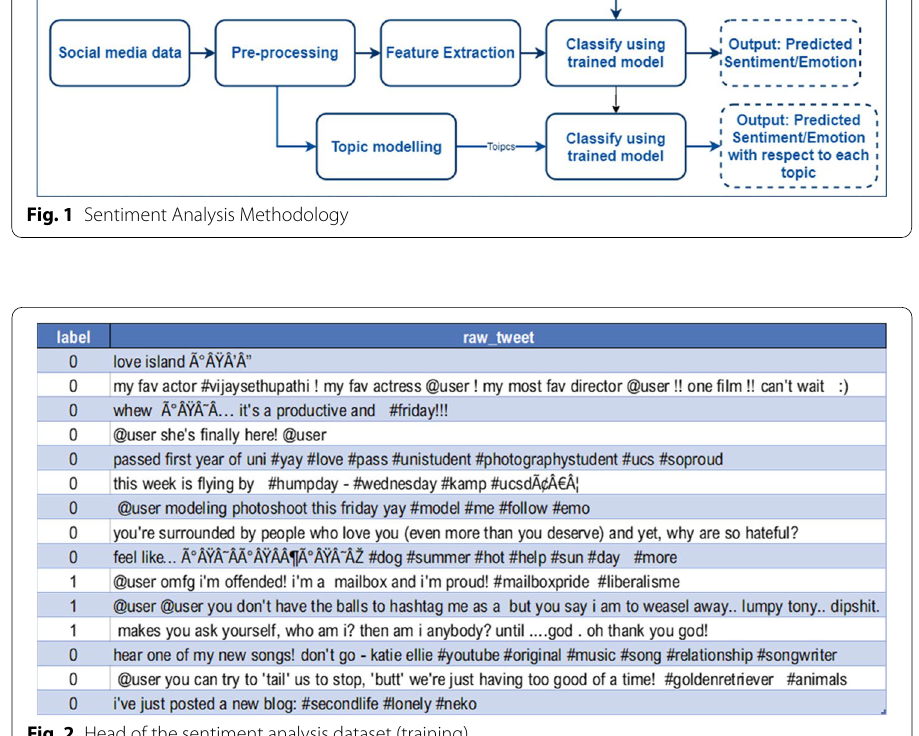
Fig. 2 Head of the sentiment analysis dataset